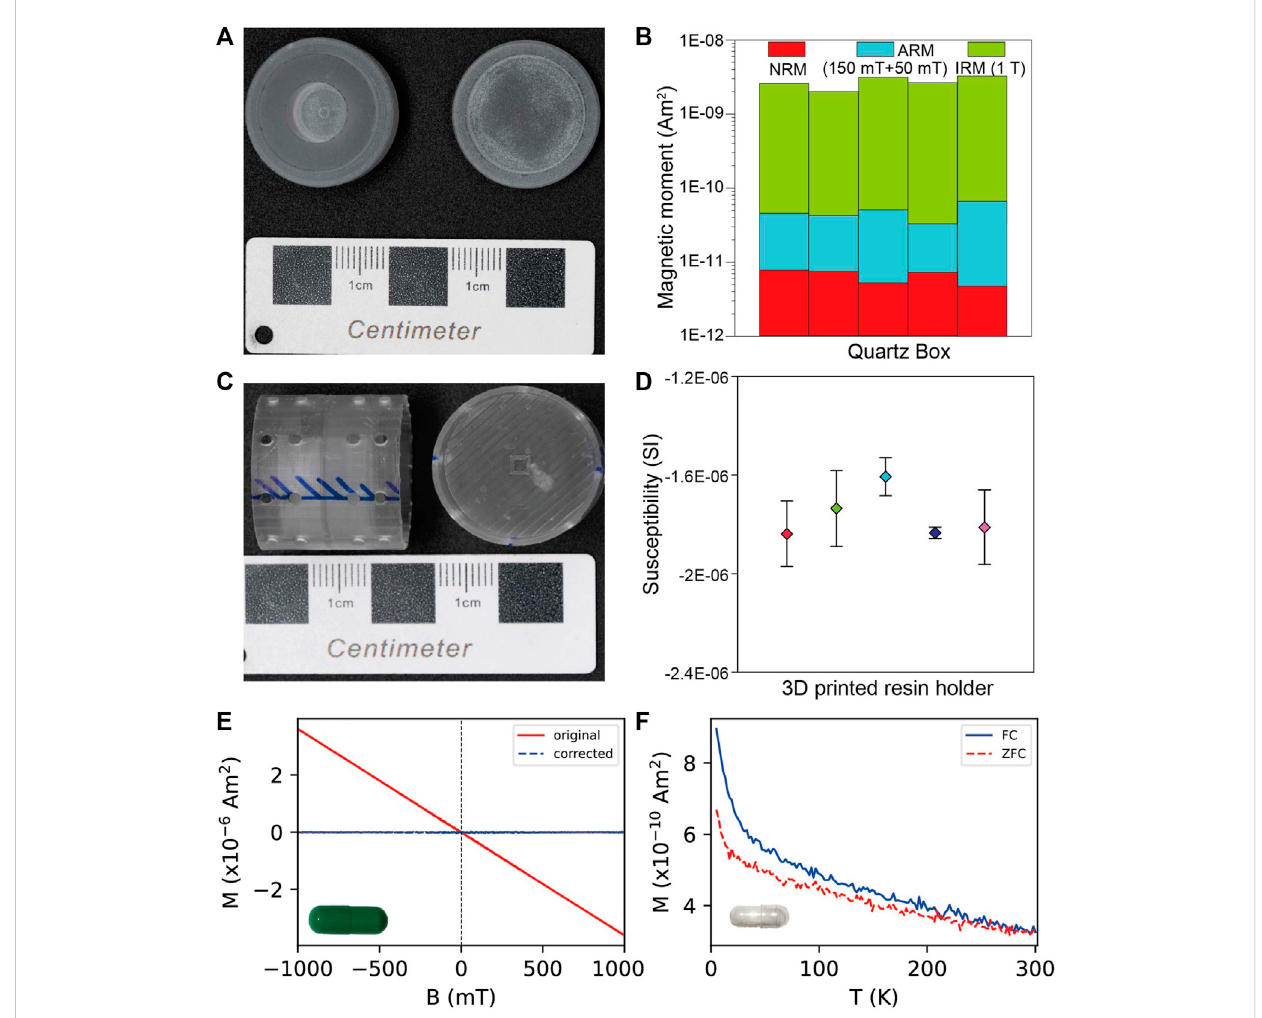
FIGURE 2 (A) Picture of the customized quartz box. (B) The intensity of NRM, ARM and IRM of representative quartz boxes. (C) Picture of 3D printed resin cylinder. (D) Mean magnetic susceptibility of representative 3D printed resin boxes and its standard deviation. (E) Representative hysteresis loop of a capsule for Micromag 3900 VSM. (F) Representative in- fi eld and zero- fi eld magnetization curves of a low-temperature capsule for